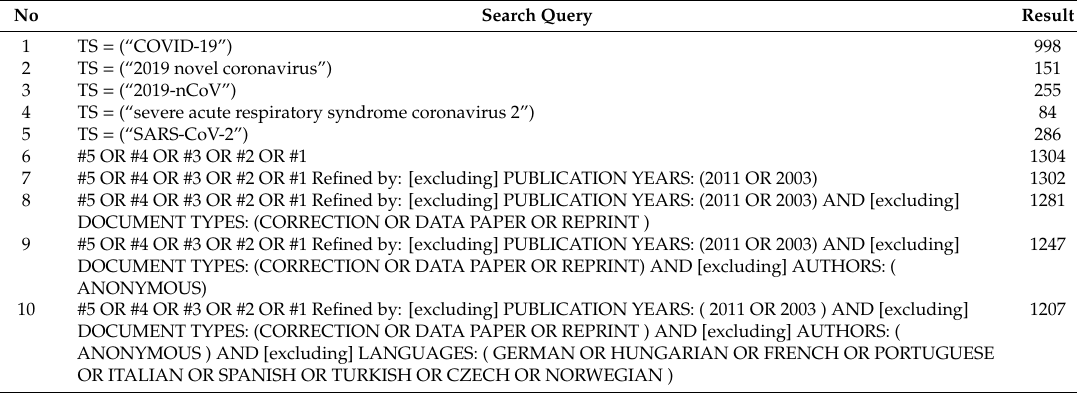
Table A1. Search query (Web of Science).